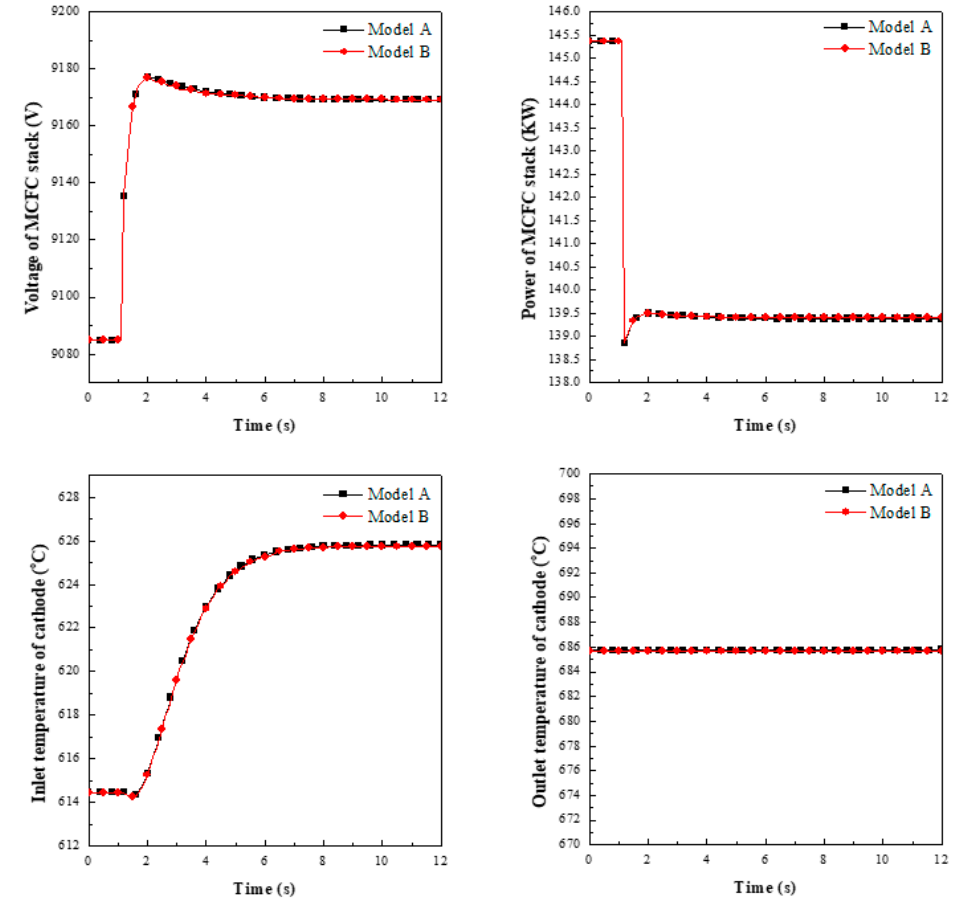
Figure 7. The step-down of MCFC current density—comparison of the fast time scale transient responses of the cell voltage, the fuel cell stack power, the inlet temperature of the cathode, and the outlet temperature of the cathode between the MCFC-MGT model and the MCFC-MGT model based on the Sim–Stim interface model.